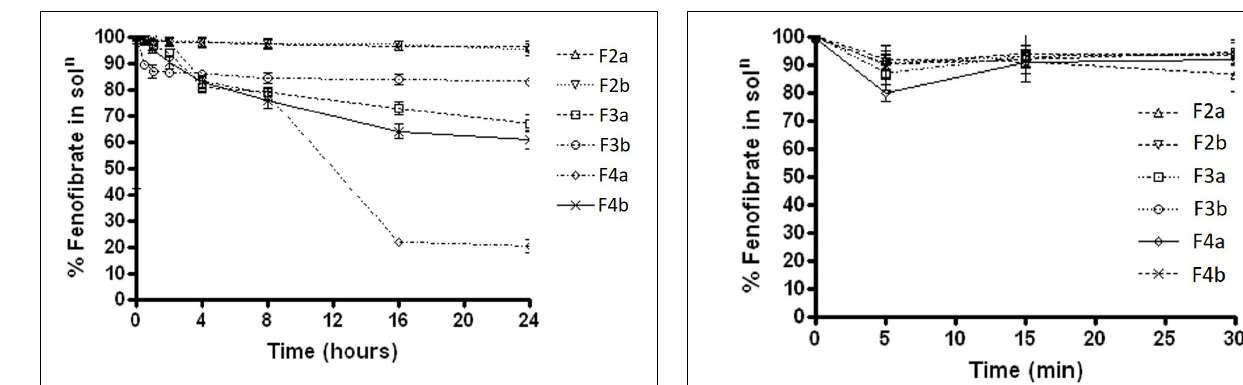
FIGURE 7 | Fenofibrate concentration (mg/mL) in solution during 30 min lipolysis experiments under fed condition. The formulation represent F2a- C70: CM (7:3)/TO106V (1/1), F3a- C70: CM (7:3)/ HCO-30 (1/1), F2b- K70:I742(7:3)/TO106V(1/1), F3b- K70:I742(7:3)/ HCO-30 (1/1), F4a- CMCM/HCO-30 (1/1), and F4b- I742/ HCO-30 (1/1) respectively. Data are presented as mean ± SD, ( n = 3).